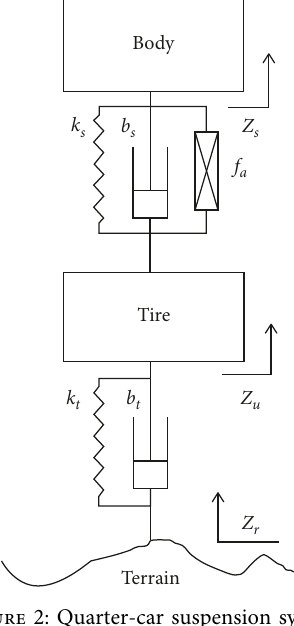
Figure 2: Quarter-car suspension